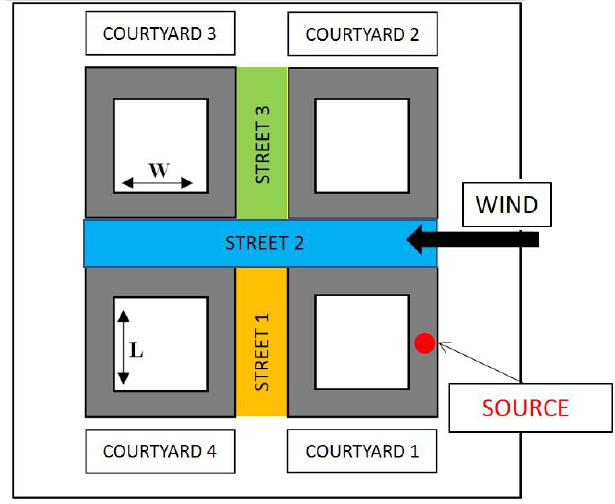
Fig. 1. Sketch of the group of courtyards, with the relevant dimensions, the pollutant source location, the wind direction, the names of the courtyards and the names of the